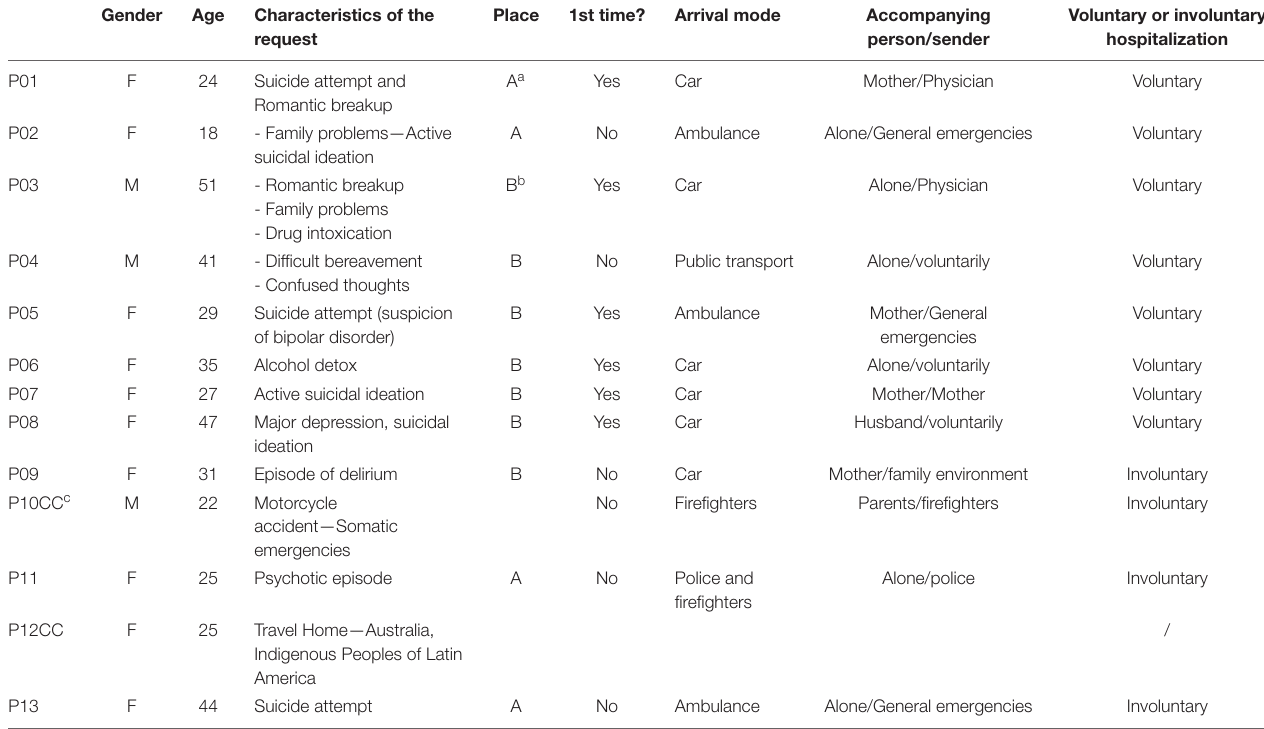
TABLE 1 | Characteristics of